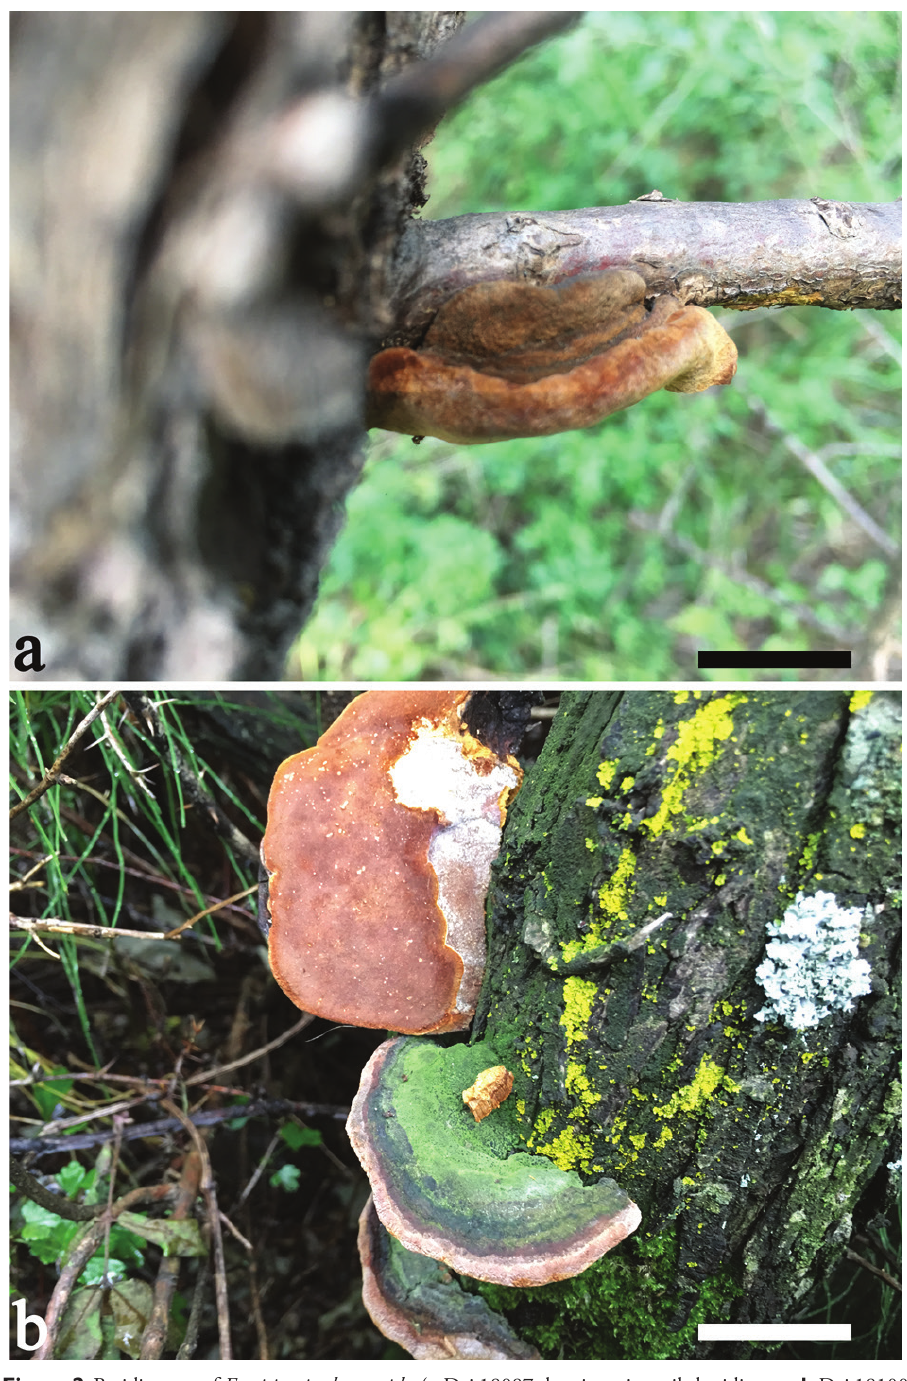
Figure 2. Basidiocarps of Fomitiporia rhamnoides ( a Dai 18087 showing a juvenile basidiomata b Dai 18100 showing the mature basidiomata; Scale bars: 3